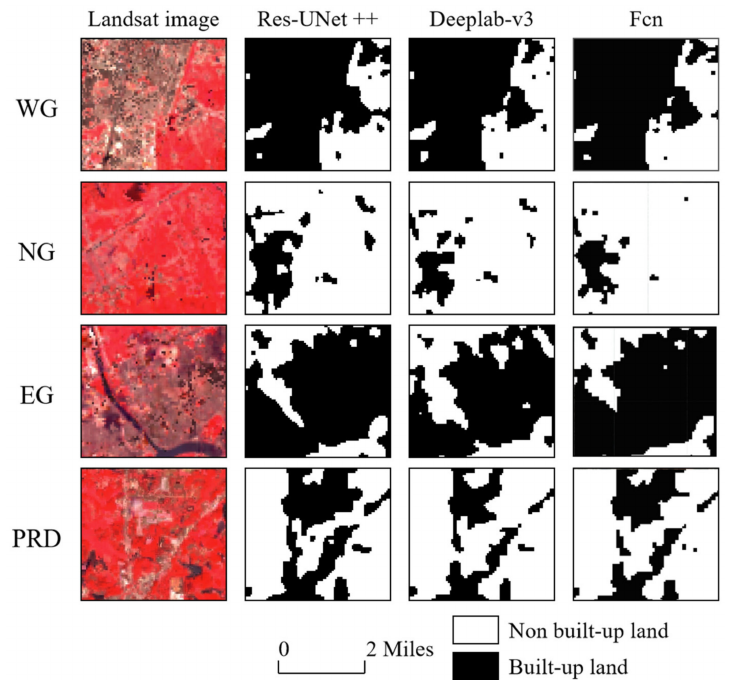
Figure 11. Examples of built-up land produced by Res-UNet++, Deeplab-v3 and FCN in 2020.